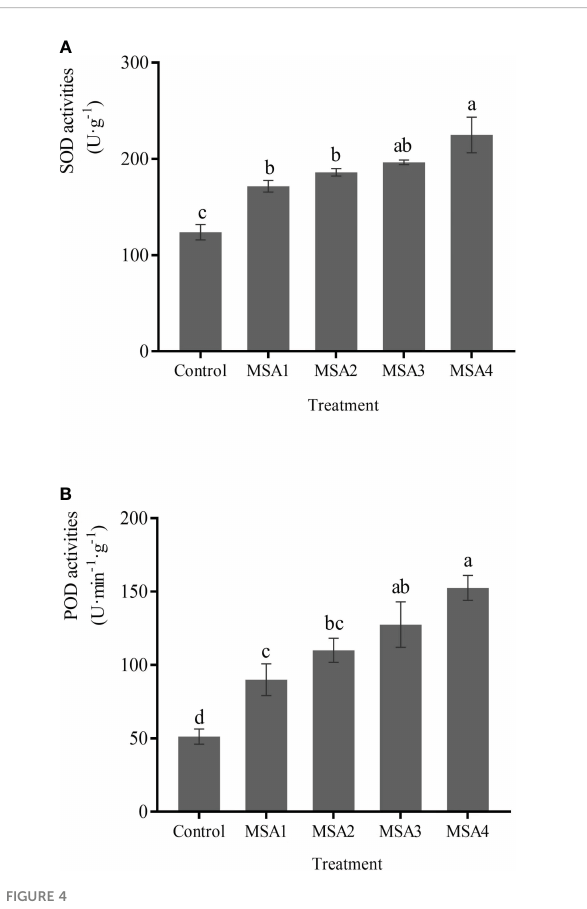
FIGURE 4 2 O 2 content; (B) , Changes in the activities of antioxidant enzymes in Trollius chinensis leaves upon saline-alkaline stress. (A) , SOD activities; (B) , POD activities.